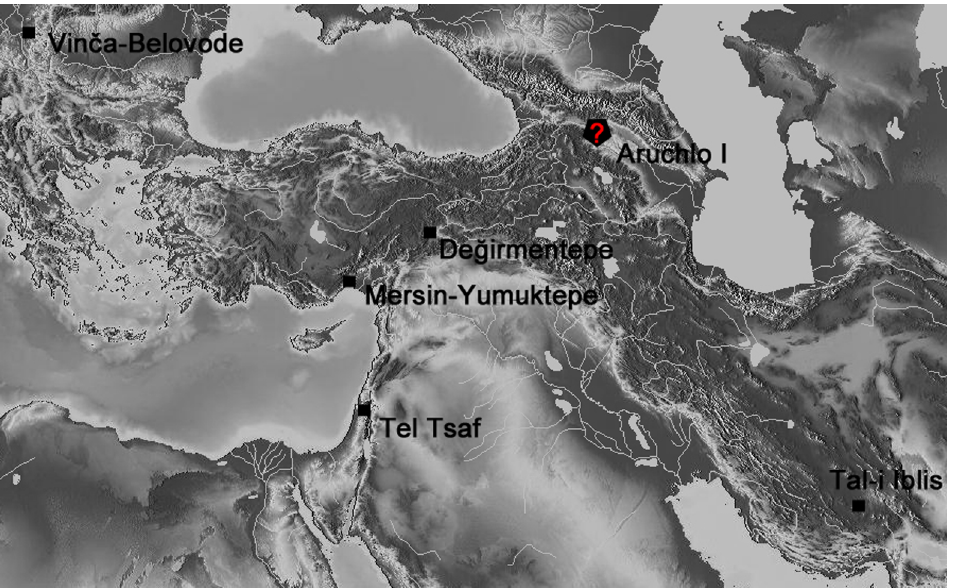
Figure 1. Map showing the main sites mentioned in the text: the distribution of smelted copper objects during the late 6 th –early 5 th millennia CalBC.